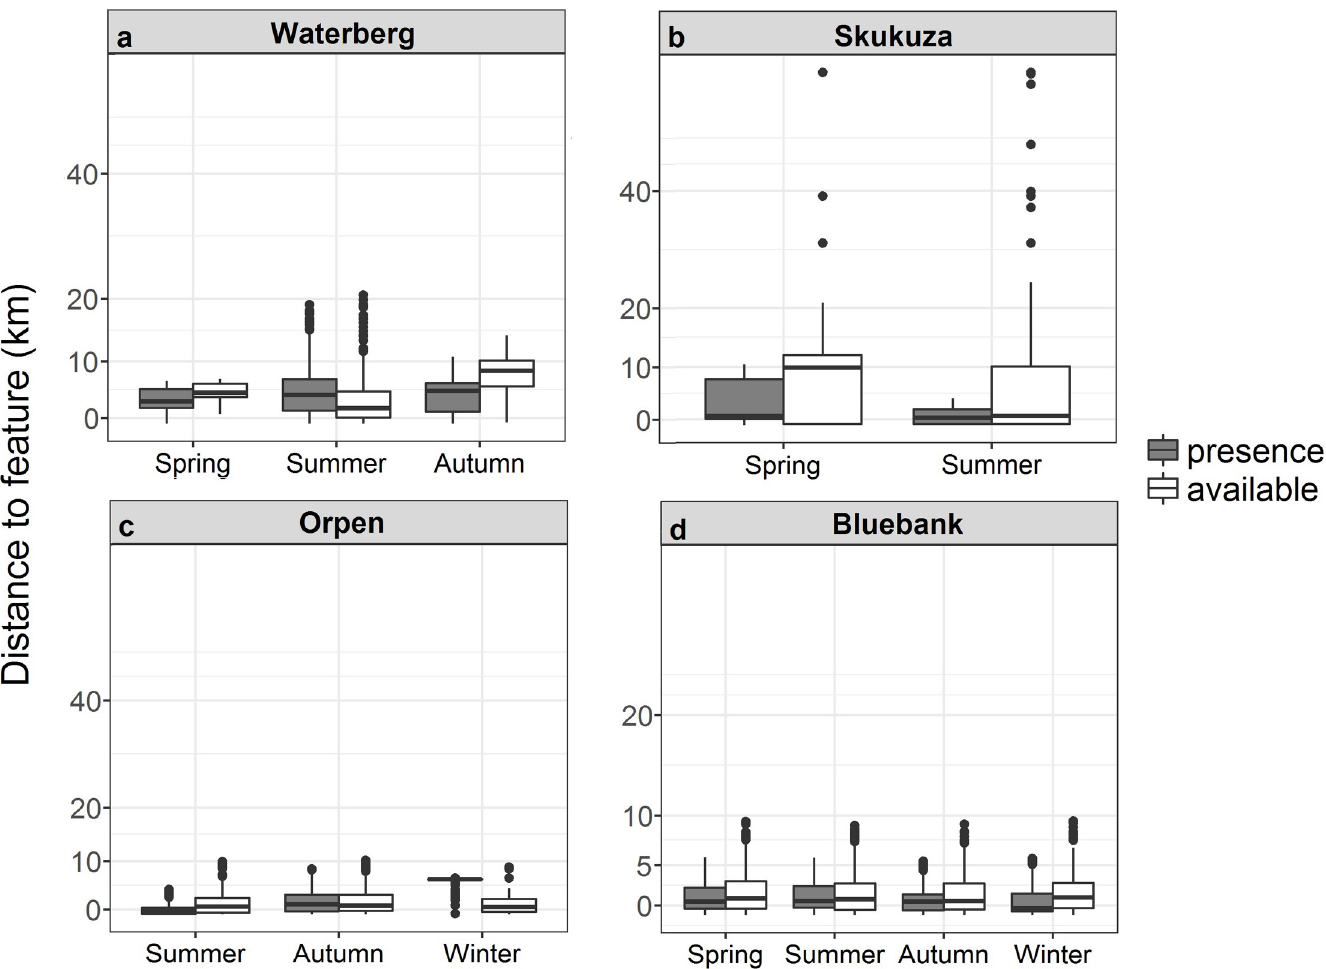
Fig 5. African wild dog pack presence and availability data in areas of roads for the a) Waterberg, b) Skukuza, c) Orpen and d) Bluebank packs across different seasons in the Limpopo and Mpumalanga Provinces, South Africa. Boxplots show medians (dark horizontal bars), 1 st and 3 rd interquartiles (boxes), 95% CI (whiskers) and outliers (dots). Presence data are indicated by coloured